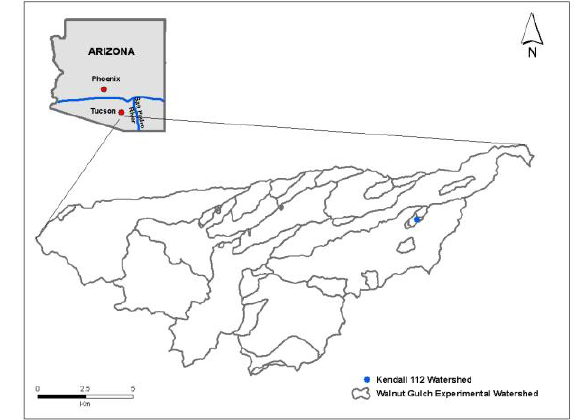
Figure 1. Location of Kendall 112 watershed in USDA ARS